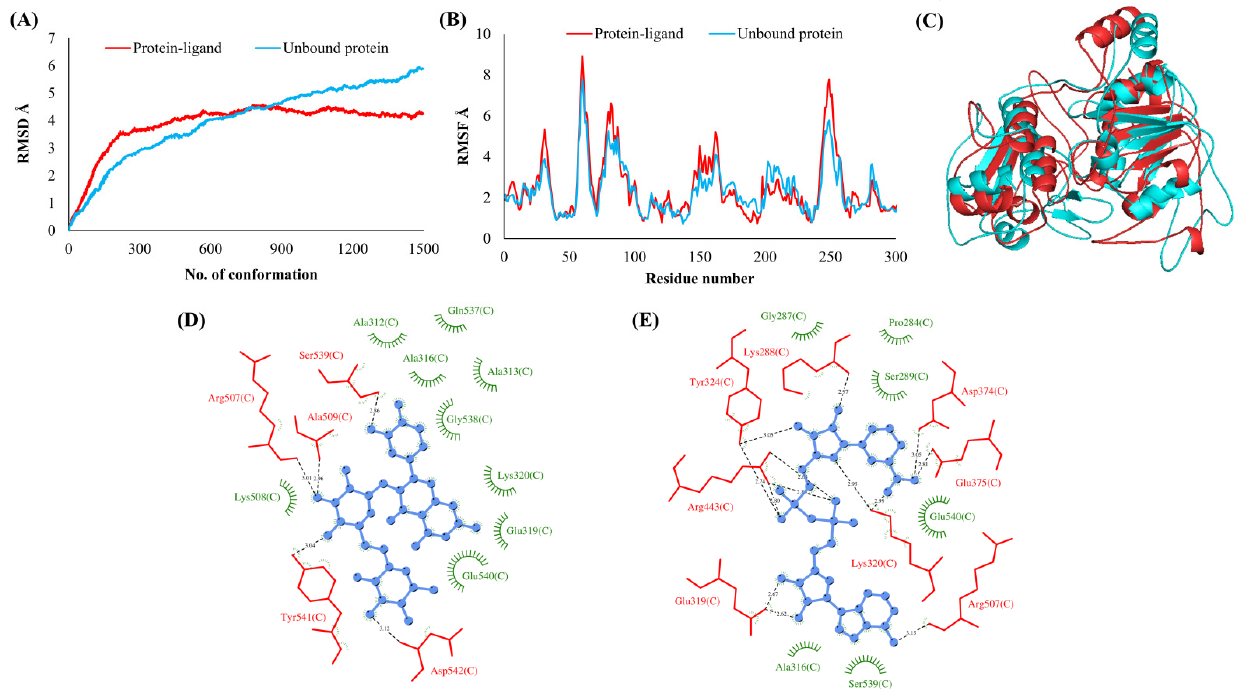
Figure 4. RNA binding protein (NSP9). ( A ) RMSD plot of unbound and ligand-bound protein ( B ) RMSF plot of unbound and ligand-bound protein ( C ) Superimposition of unbound and ligand-bound protein ( D ) Molecular interactions of pro- tein with Rutin ( E ) Molecular interactions of protein with NADH.